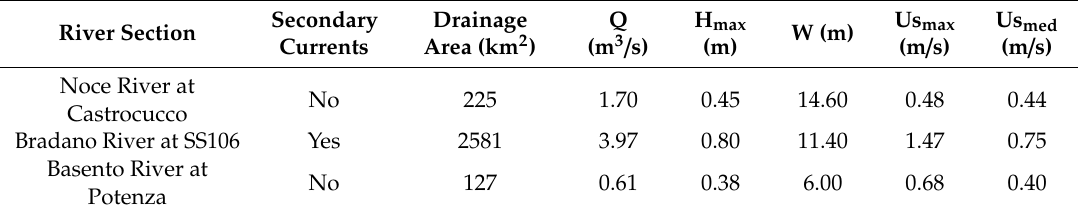
Table 1. Main river flow characteristics in three case